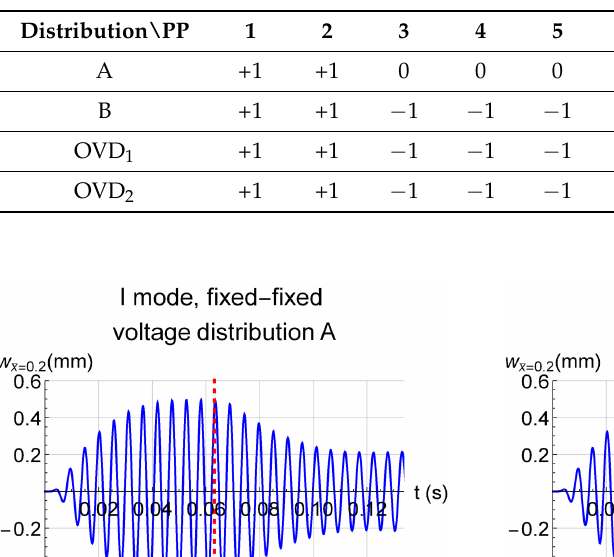
Table 4. Selected voltage distributions for the damping effectiveness comparison illustrated in Figure 9 and considering the first eigenmode excitation of the fixed-fixed beam. OVD 1 and OVD 2 are the optimal voltage distributions when the mode is excited, respectively, for the first and the second mode.